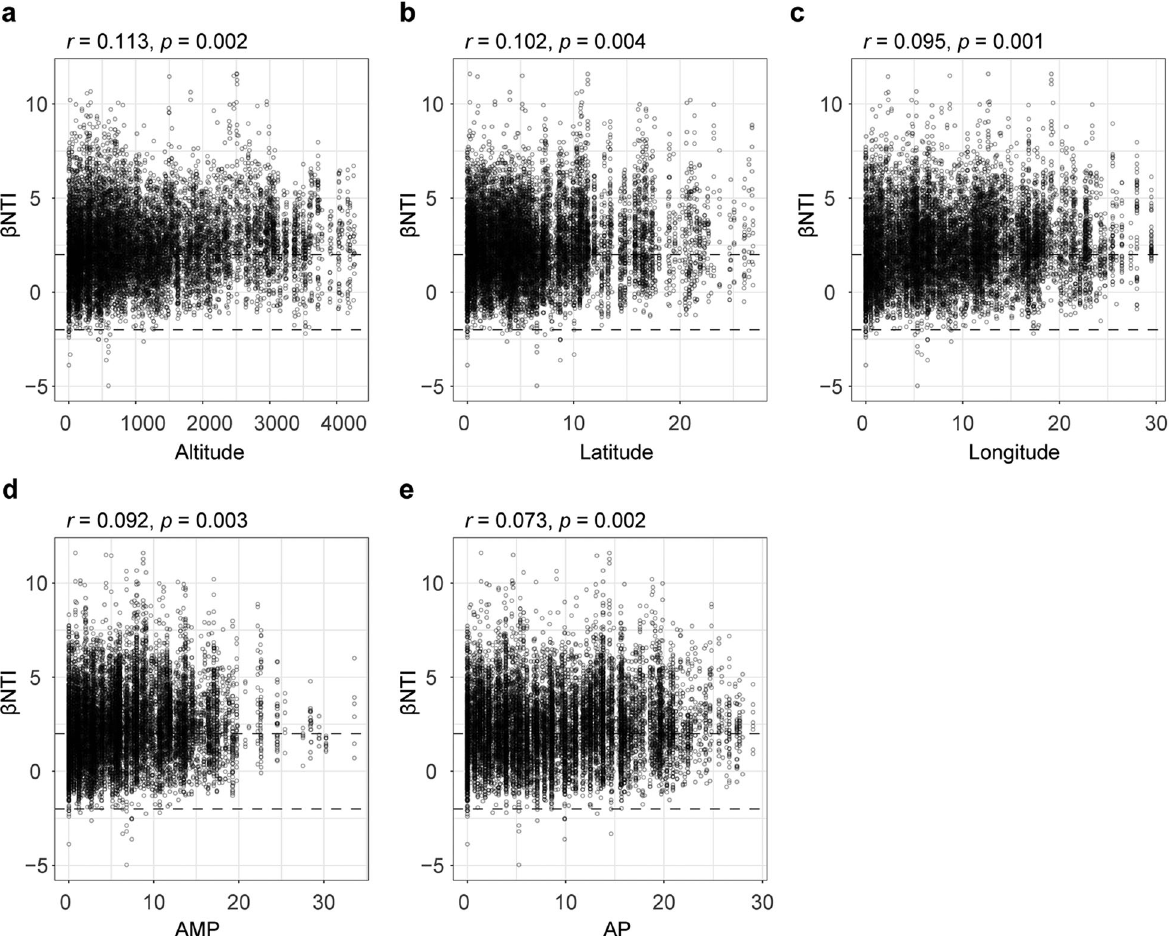
Fig. 7 Effects of environmental factors on stone fl y fungal community assembly. Mantel analysis used to evaluate the correlation between the β -Nearest Taxon Index ( β NTI) and the multiples environmental variables: ( a ) altitude, ( b ) latitude, ( c ) longitude, ( d ) annual mean temperature (AMT) and ( e) annual mean precipitation